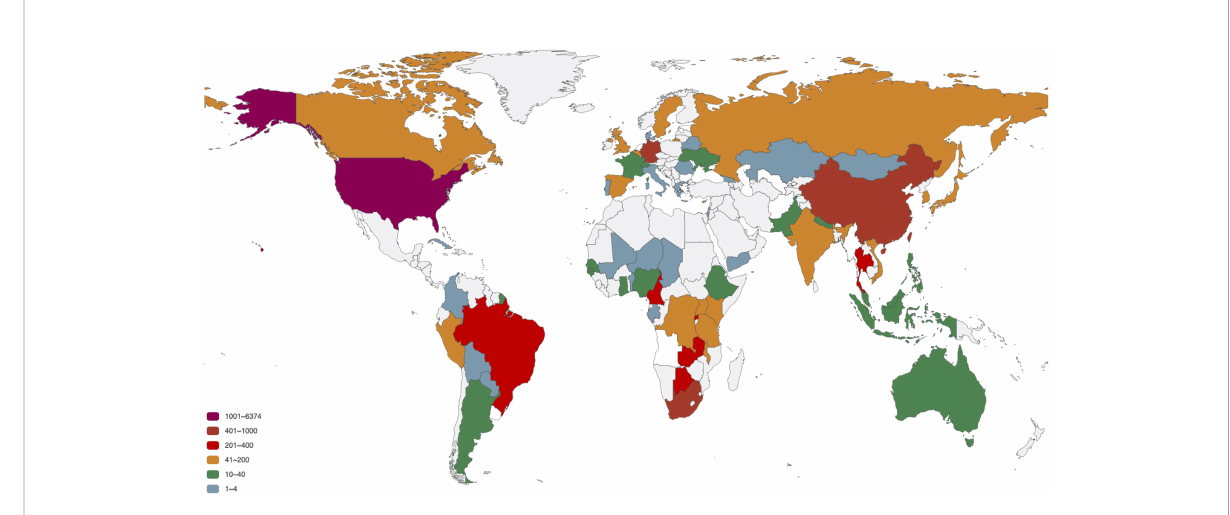
FIGURE 3 The number of HIV-1 complete genomes in each country. The 11897 sequences in our dataset are distributed in 78